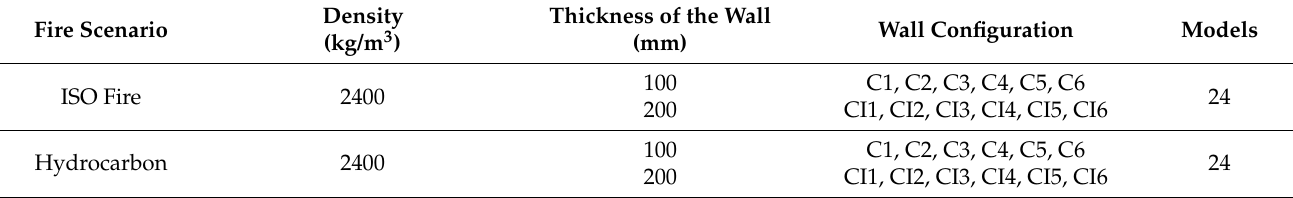
Table 4. Outline of parametric study.